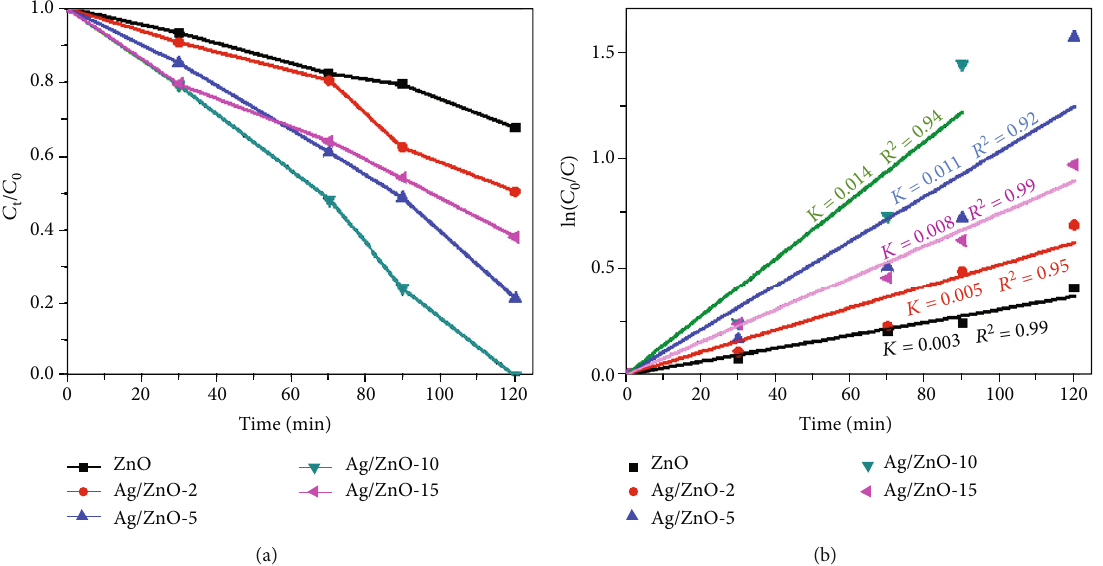
Figure 6: (a) Photodegradation of BPA in ZnO and Ag/ZnO and (b) the kinetic curves (the reaction conditions: dosage catalyst 0.5g/L, BPA concentration of 20 mg/L, and pH = 6 : 0